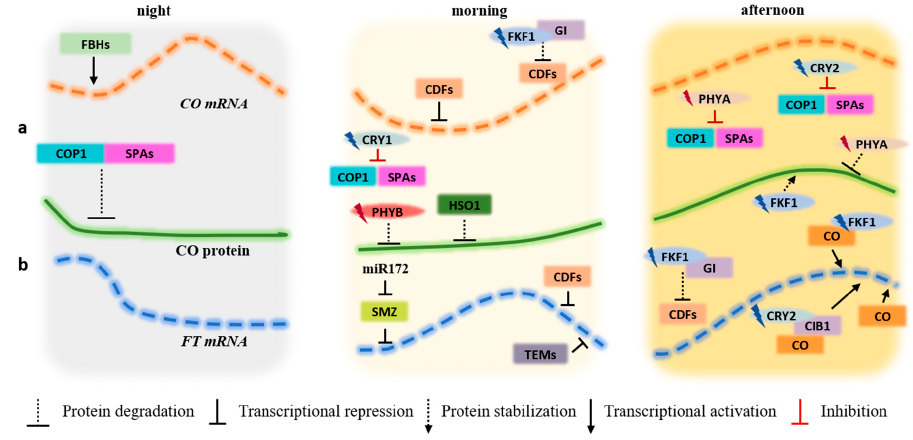
Figure 2. CO and FT photoperiodic regulation under LD during the night, morning, and afternoon periods. ( a ) Transcriptional ( CO mRNA) and post-translational (CO protein) regulation. ( b